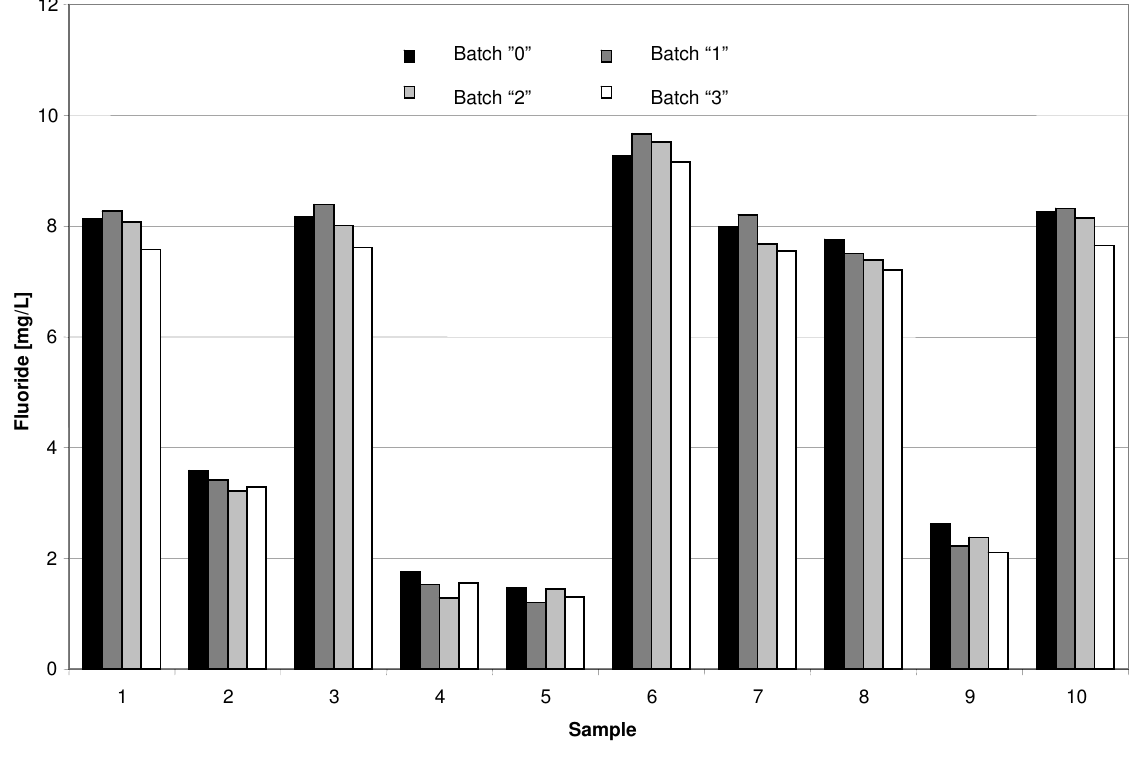
Fig. 2 The changes of fluoride content in toothpastes during 3 month